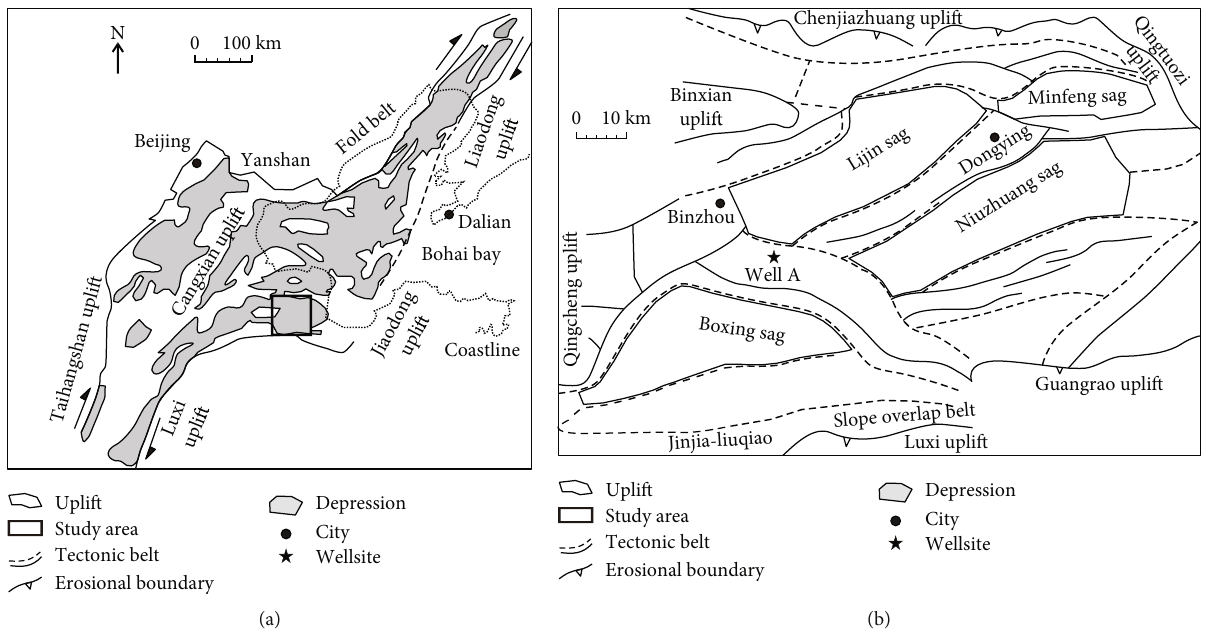
Figure 1: Geological background of the Es4u shale within the Dongying Depression. (a) Location of the Dongying Depression, Bohai Bay Basin, Eastern China. (b) Structural map of the Dongying Depression, including the position of the wellsite [21,